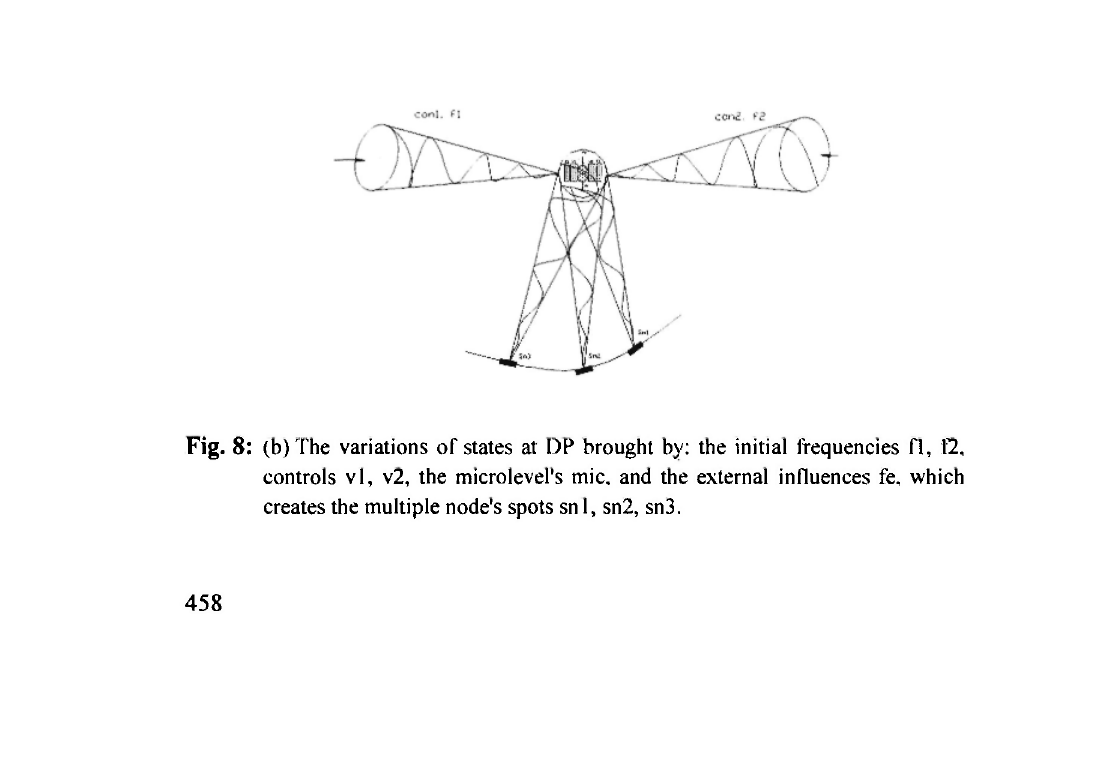
Fig. 8: (a) An elementar, schema of assembling a pair of frequencies encoded into the spot-node (sn) by applying both regular (vl, v2) and impulse controls (<5vl, dv2) (with schematic location of the corresponding cone's 1, 2 spirals with their initial frequencies fl,f2; cd-chaotic dynamics created by the superimposing ft.(2 with the chaotic attractor ca.